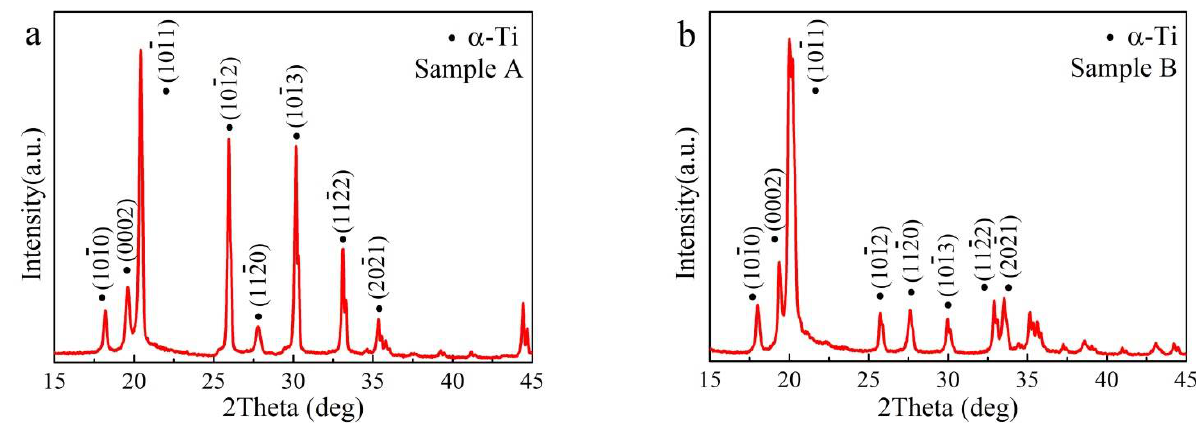
Figure 3. XRD pattern of PBF-EB AM Ti6Al4V alloy: ( a ) linear scanning strategy (sample A), ( b ) linear and 90° rotation scanning strategy (sample B).